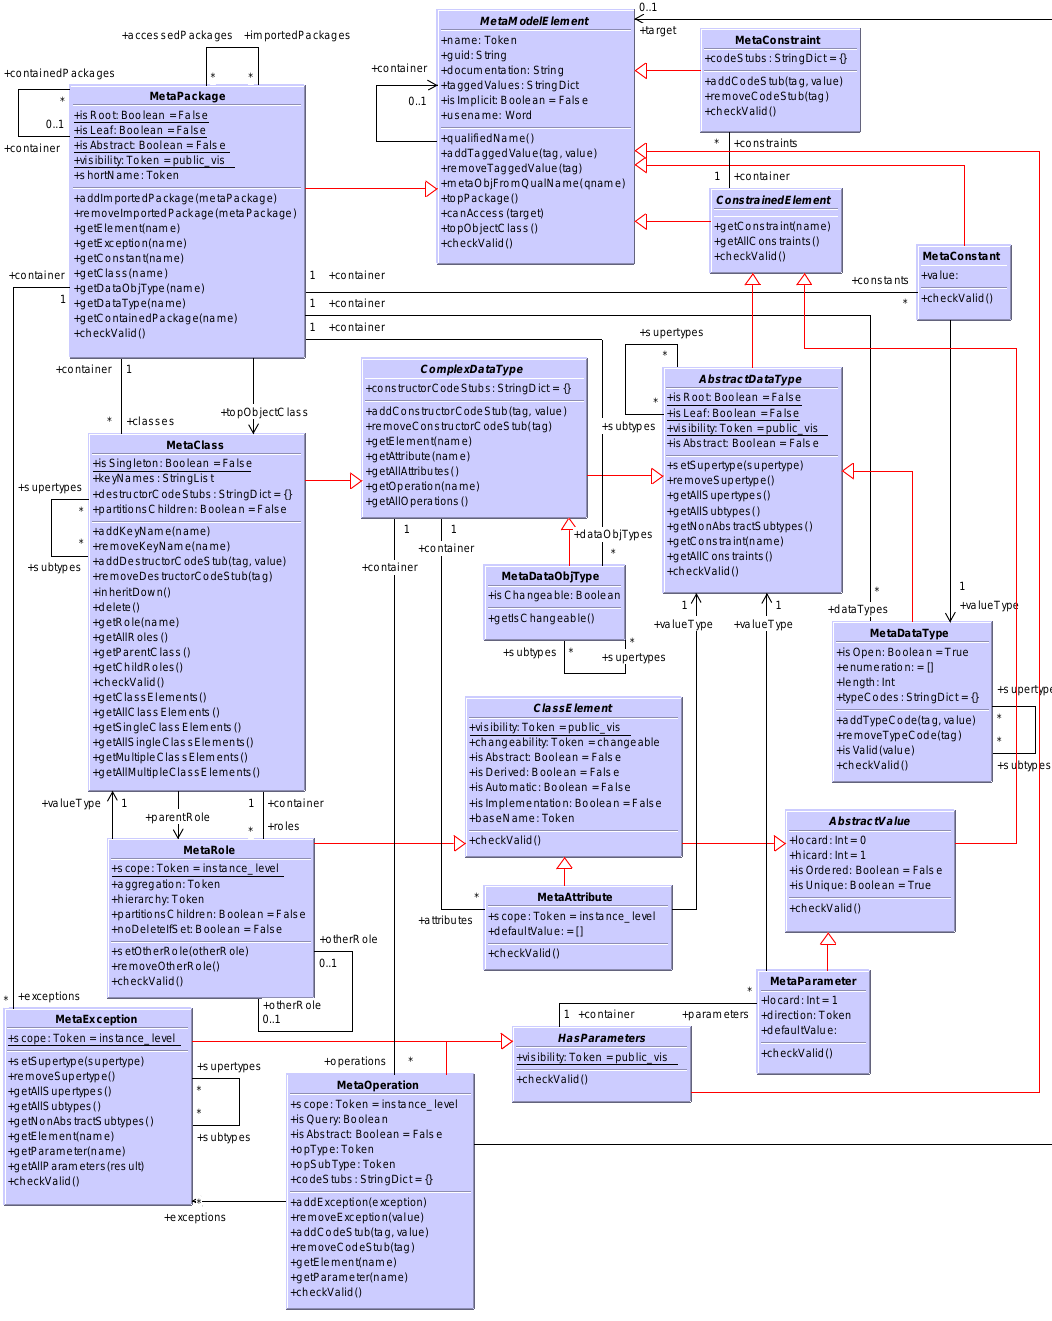
Supplementary Figure 9: shows the metamodel used for storing the data model description. Broad-headed red arrows are used for inheritance, black lines for object-to-object links. In addition to the operations shown in the diagram the model includes get and set functions for all attributes and roles (not shown). All MetaPackages must be contained within another MetaPackage, except for the topmost one which serves as root. Underlined attributes are not currently used and are fixed at the given default values – they are implemented as class (static) attributes. For portability the MetaModel has been limited to single inheritance, which means that some type constraints could not be represented properly in the diagram – these are enforced separately by the underlying code. Specifically, MetaAttribute.valueType must be a MetaDataObjType or MetaDataType, and MetaOperation.target must be an AbstractDataType, a ClassElement, or a